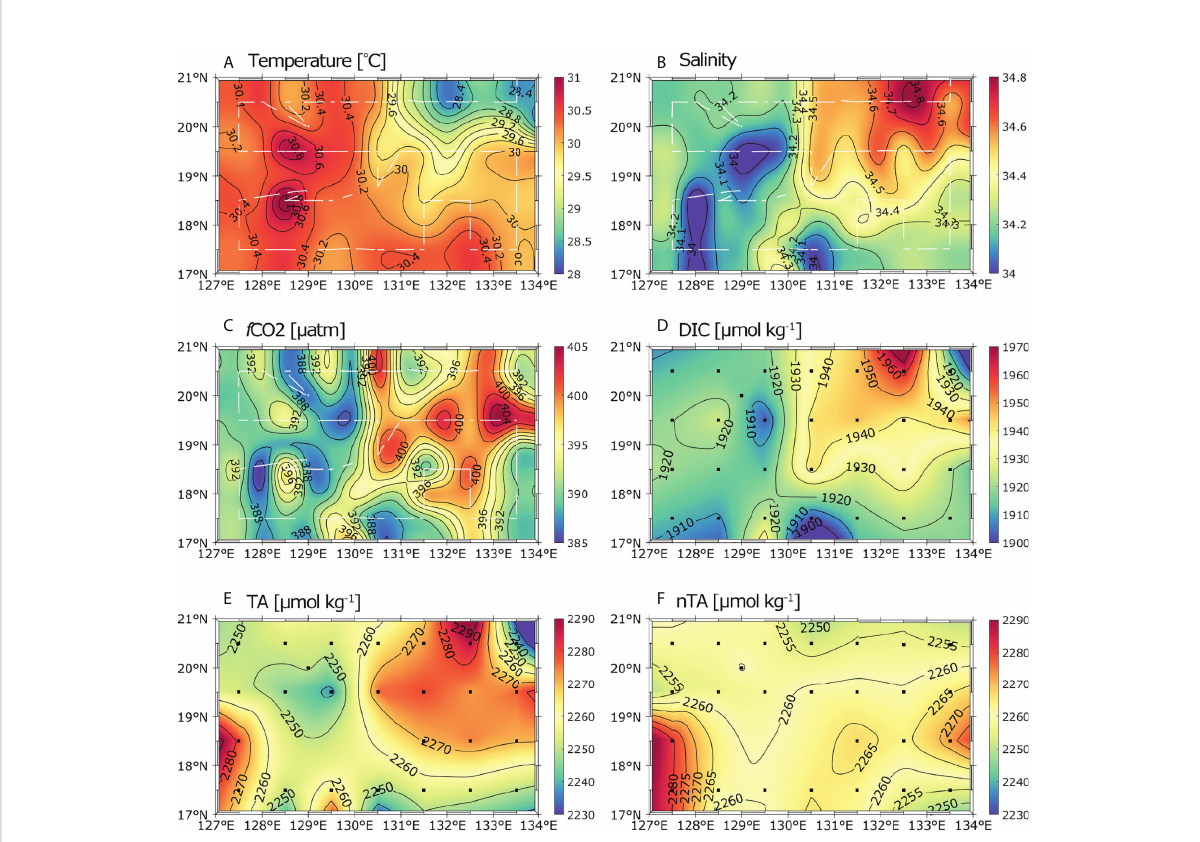
FIGURE 2 Surface distributions of temperature (A) , salinity (B) , fCO2 (C) , DIC (D) , TA (E) , and salinity-normalized TA (nTA, F) in the study area. Underway and discrete measurements are shown in white lines (A – C) and black dots (D, E) ,